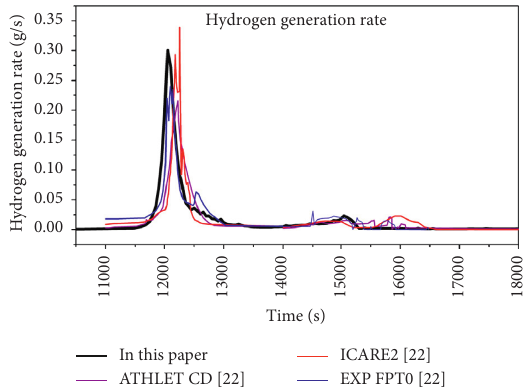
Figure 14: Hydrogen generation rate.